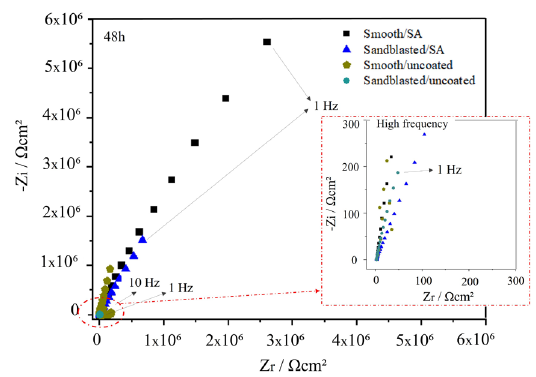
Figure 4. Nyquist diagram for smooth and sandblasted substrates with SA coating compared to the uncoated substrates, analyzed in 48 h of immersion in 0.1 mol / L NaCl